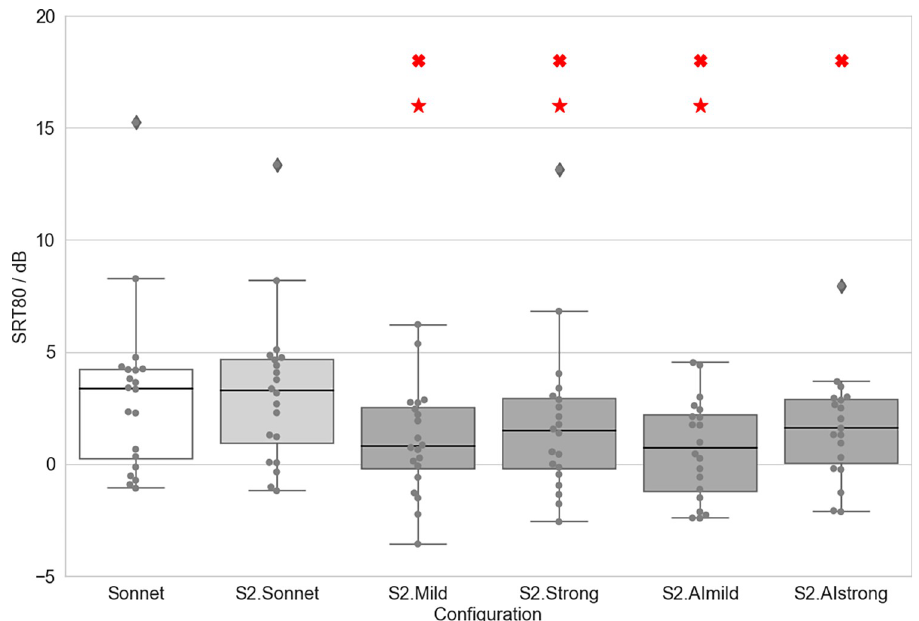
Fig 5. SRT80 observed in the OLSA S0N ± 45N ± 135 for each configuration. A cross marks a significant difference compared to S2.Sonnet. A star marks a significant difference compared to the SONNET. Boxplots show median values as well as first and third quartiles. Whisker bars show minimum and maximum values within 1.5 interquartile ranges below and above the first and third quartile. Diamonds show